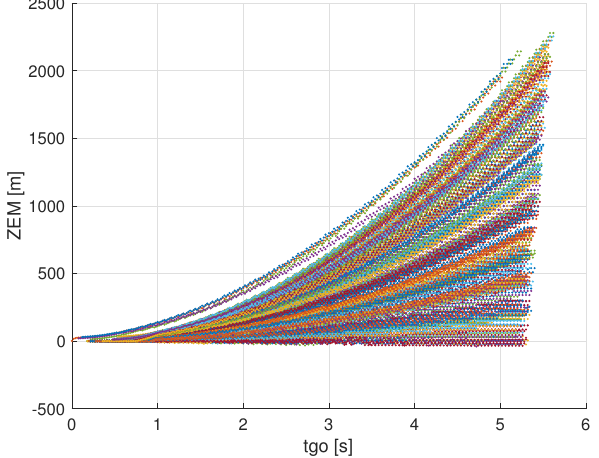
Figure 3. True ZEM for the simulated cases.